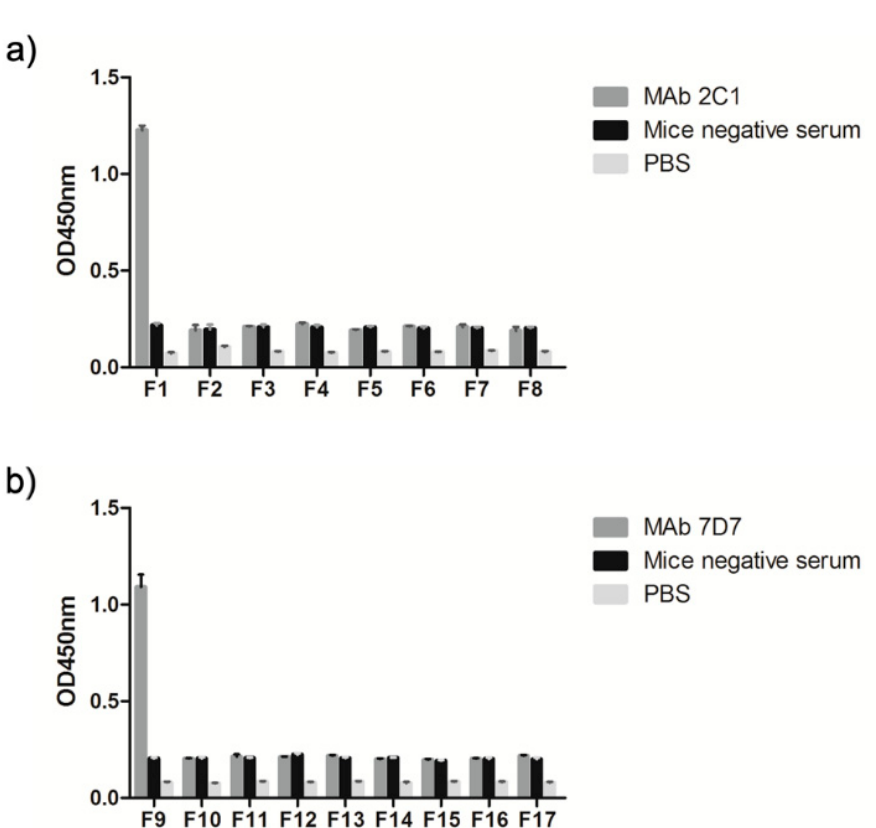
Figure 4. Truncated peptides define the minimal linear epitope recognized by mAb 2C1 or 7D7. ( a ) ELISAs were performed using synthetic peptides (4–10 aa) with different deleted aa residues from the N and/or C termini of the peptide 634 RIKQRETPAL 643 to determine the minimal linear epitope sequence recognized by mAb 2C1. ( b ) ELISAs were performed using synthetic peptides (4–10 aa) with deleted different aa residues from the N and/or C termini of the peptide 736 PESYKDRMYS 745 to determine the minimal linear epitope sequence recognized by mAb 7D7.